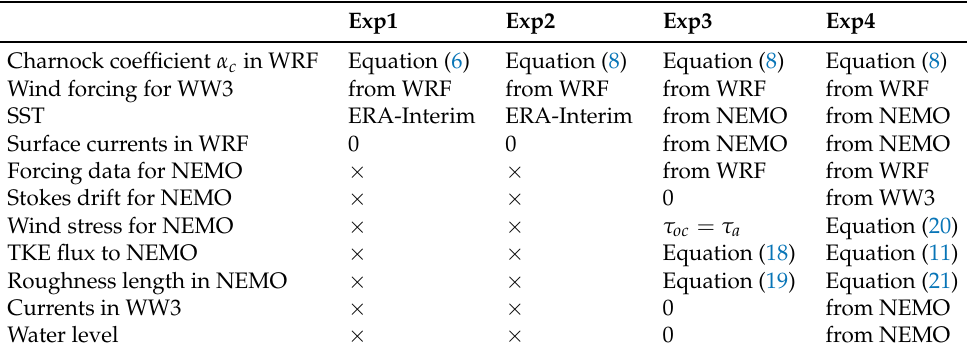
Table 1. The Atmosphere–Wave–Ocean (AWO) interaction processes in the four experiments. Exp1 Exp2 Exp3 Exp4 Equation